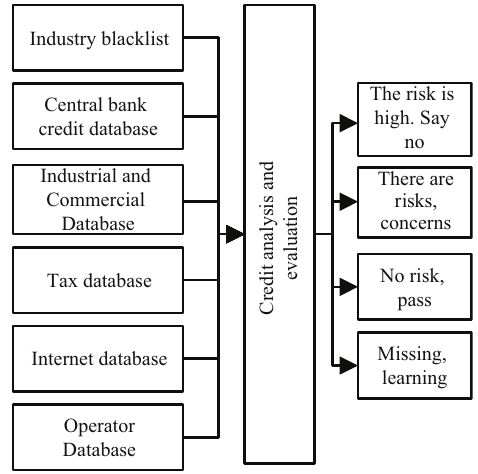
Figure 1: Risk assessment model of venture capital fi nancing for small and medium - sized enterprises.